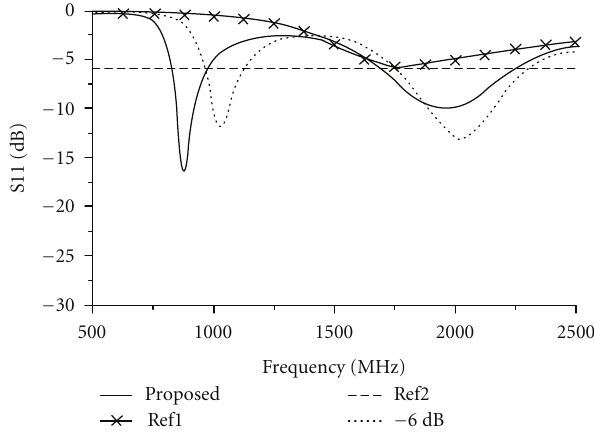
Figure 5: Comparison of the proposed antenna with two reference antennas.